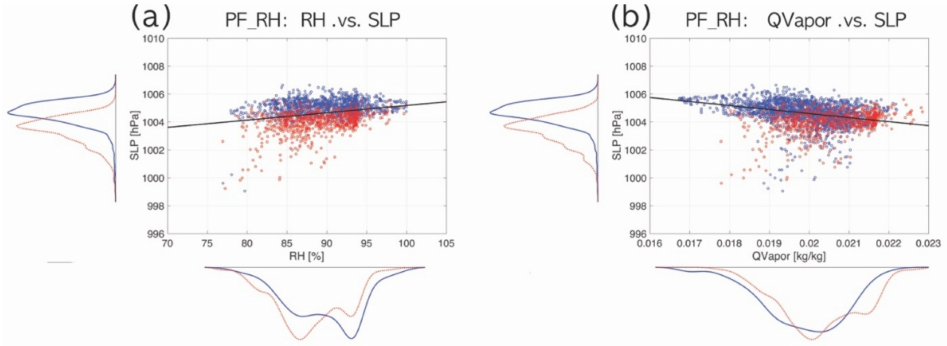
Figure 17. ( a ) RH and ( b ) mixing ratio (x-axis) at the northwest region of the TC center sampled from the background ensemble forecast (blue dot and blue line) and the PF_RH ensemble analysis ensemble (red dot and red